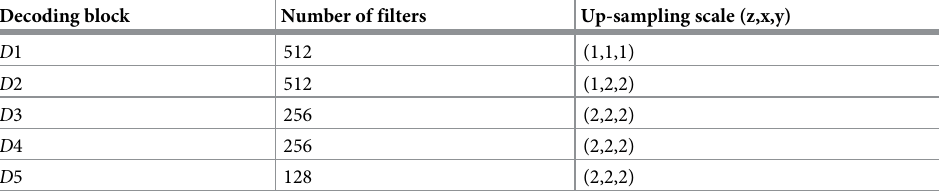
Table 5. The number of filters and up-sampling scales that were used in the Vox2Vox GAN’s decoding blocks. Decoding